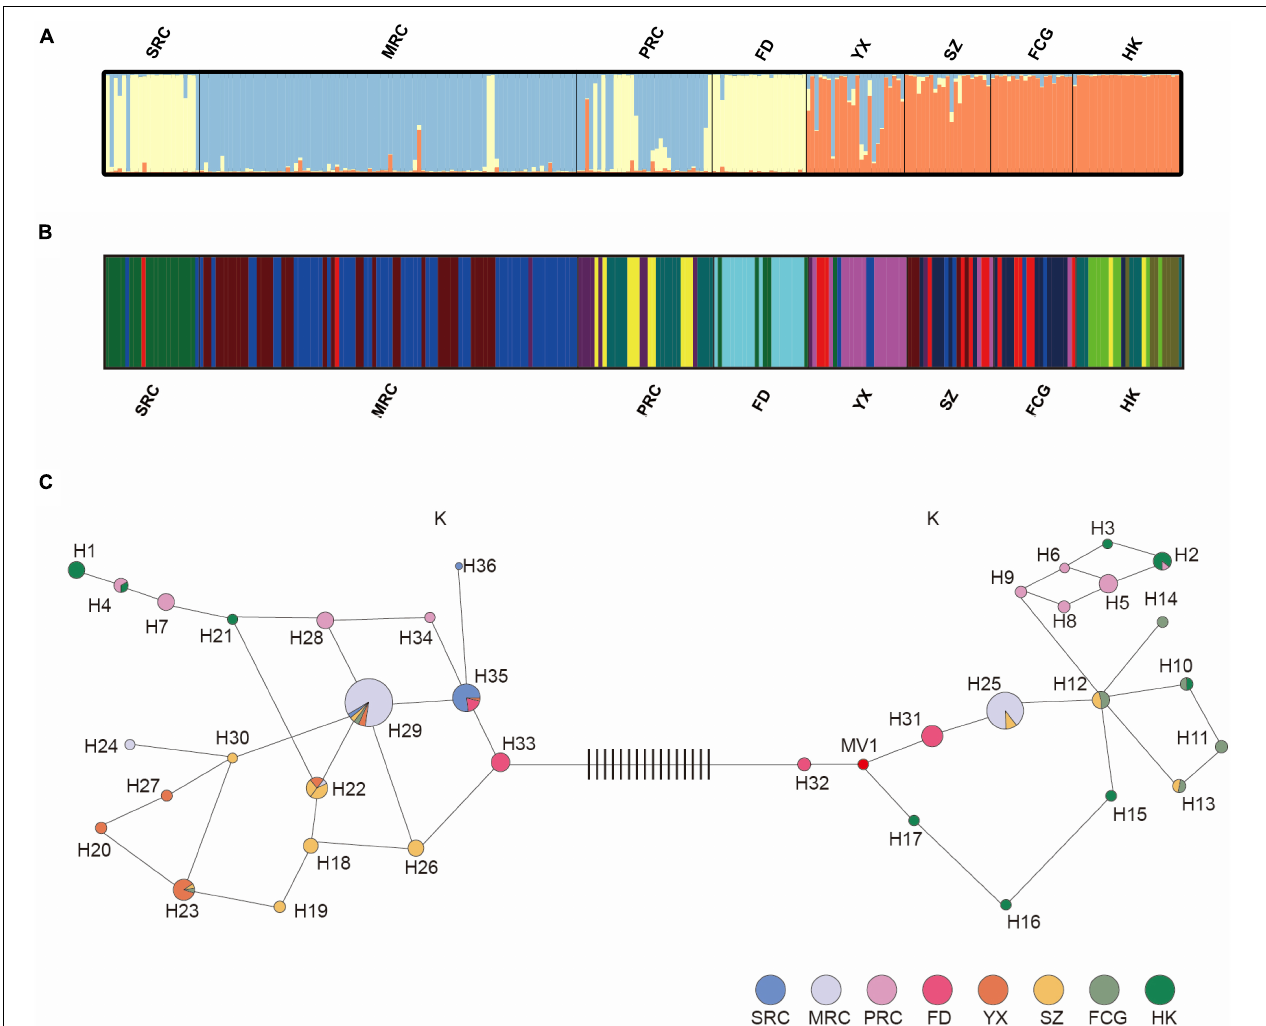
FIGURE 3 | Estimated genetic structures of six populations based on nine nSSR loci (A) and on six cpSSR loci (B) . (C) Plastid haplotype network of YQ and five natural populations, each circle represents a haplotype, and the color within the circle represents the populations or groups that share that haplotype. Black vertical lines between haplotype 32 and 33 represent mutation steps. See Table 1 for population